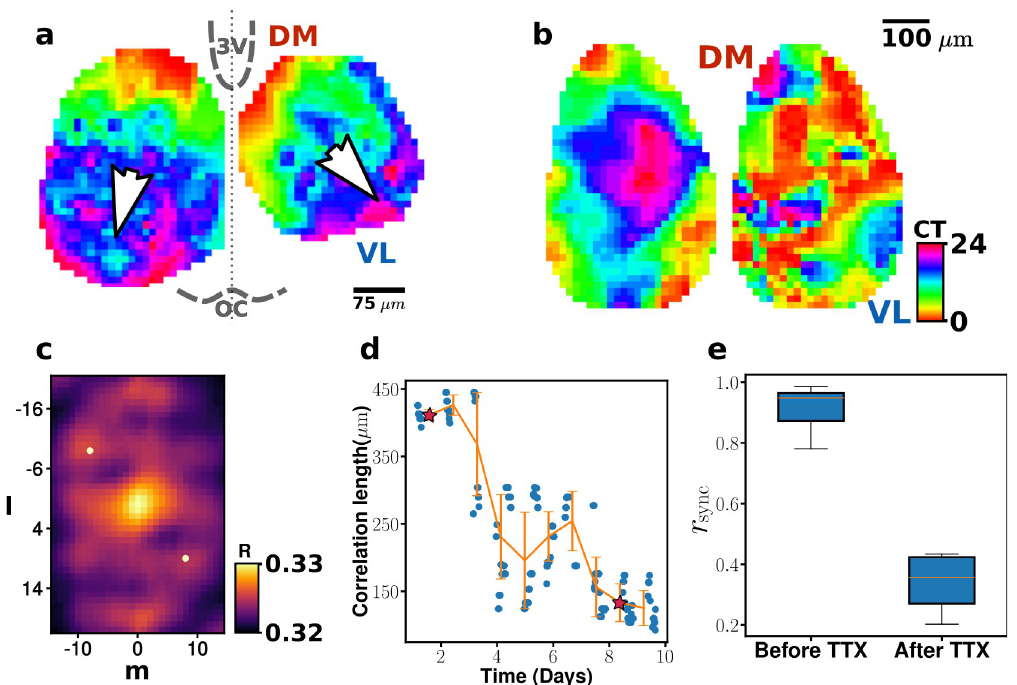
Fig 1. Circadian phase waves supported by mouse SCNs and their phase disintegration in the presence of TTX. (a) A 2D circadian phase map. The SCN circadian waves propagate typically from the shell (DM region) to the core (VL region) (see S1 Movie): The direction of each white arrowhead depicts the average instantaneous direction of phase wave propagation. To find the average direction, we compute velocity vector field (optical flow) from the set of reconstructed time-lapse images using a Gunnar-Farneback algorithm [20] and average the velocity vectors. (b) Two snapshot images of circadian phase taken at day 1 and day 8 of TTX application. (c) An exemplary 2D correlation map, corresponding to the phase map of Day 8 in (b)-right. P P ð L (cid:0) 1 Þ = 2 ð M (cid:0) 1 Þ = 2 The crosscorrelation R ð i ; j Þ ¼ I ð l ; m Þ � I ð l þ i ; m þ j Þ is pseudo-color coded ( I represents the image l ¼(cid:0) ð L (cid:0) 1 Þ = 2 m ¼(cid:0) ð M (cid:0) 1 Þ = 2 grey scale and L = 43 and M = 29 define length in pixels; one pixel = 14.4 μm ). The two most prominent peaks around the center of the map are labelled by two white dots, and their average distance to the center is defined as 2D correlation length. (d) Time evolution of 2D correlation length over 10 days in the presence of TTX: The initial correlation length (~ 400 μm ) gets significantly smaller (~ 140 μm ) over several days. The star symbols mark the times for two phase maps shown in (b). The (cid:0) t = t decay . The solid decay time constant τ decay = 6.5 was obtained by fitting the data to an exponentially decaying function of C 0 e orange lines connect average data points, each of which are binned over a 20-hour time window; error bars mark standard P N deviations (e) The synchrony measure r ¼ 1 j e i � j j , where N is the total number of grid points, is much higher during sync j ¼ 1 N unperturbed natural states (0.92 ± 0.06) than TTX-treated steady states (0.42 ± 0.23). The blue bands represent interquatile range, orange lines mark the median values (0.95 and 0.36, respectively), and black lines mark the full range of data. The 10 sample nuclei (of S1 Fig) are evaluated for the statistics. (The PER2::LUC signal data shared at https://github.com/johnabel/ scn-resynchronization-data-2016 was used for (a) and (e), while the analysis presented in (b ~ d) are based on our (BJ and KJL) earlier experimental data published in Ref.